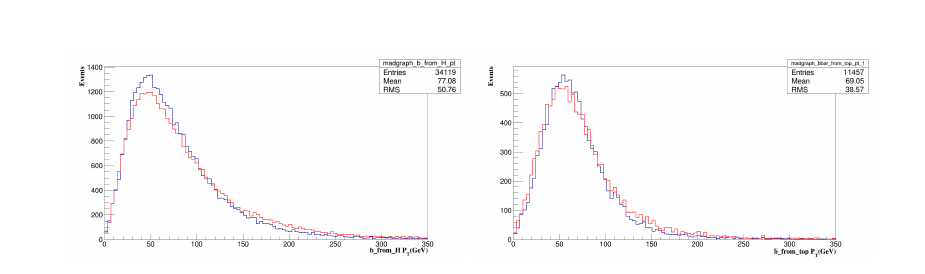
Figure 4. Transverse momenta of b-quarks from Higgs (left) and top quark (right) decays. Here and in the following figures blue histograms show the SM case, red histograms are for the ITC scenario.